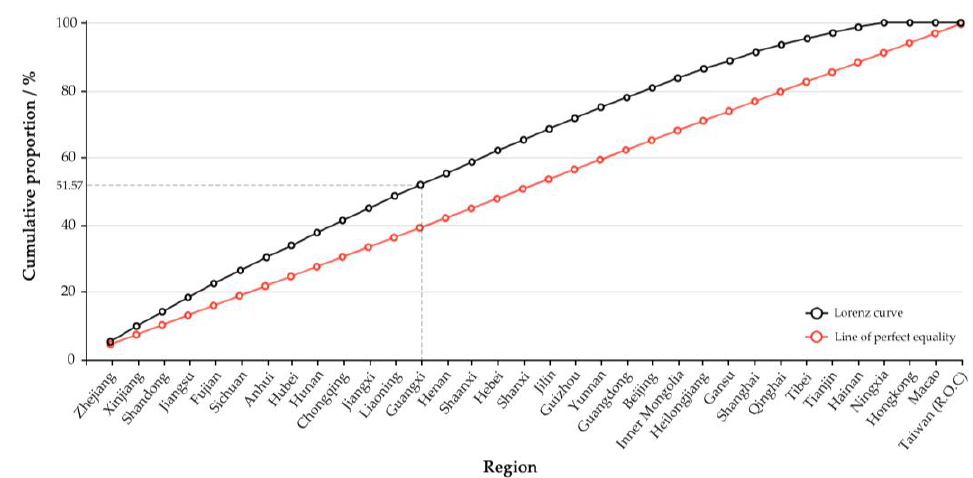
Figure 6. The Lorentz curve of beautiful leisure villages in China.